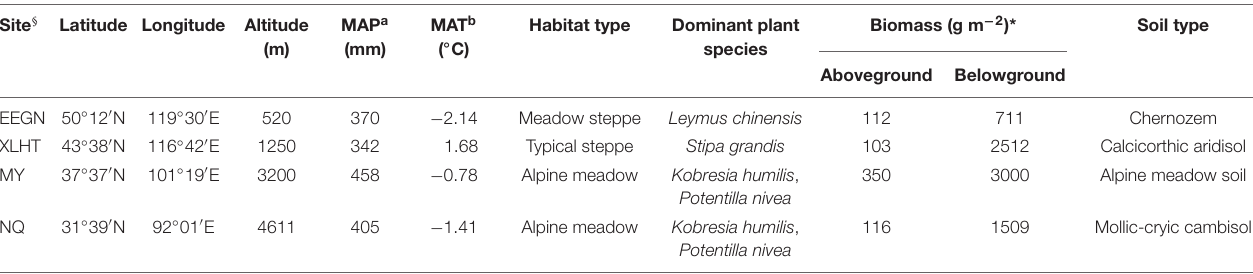
TABLE 1 | Characterization information of the natural grassland sites selected in this